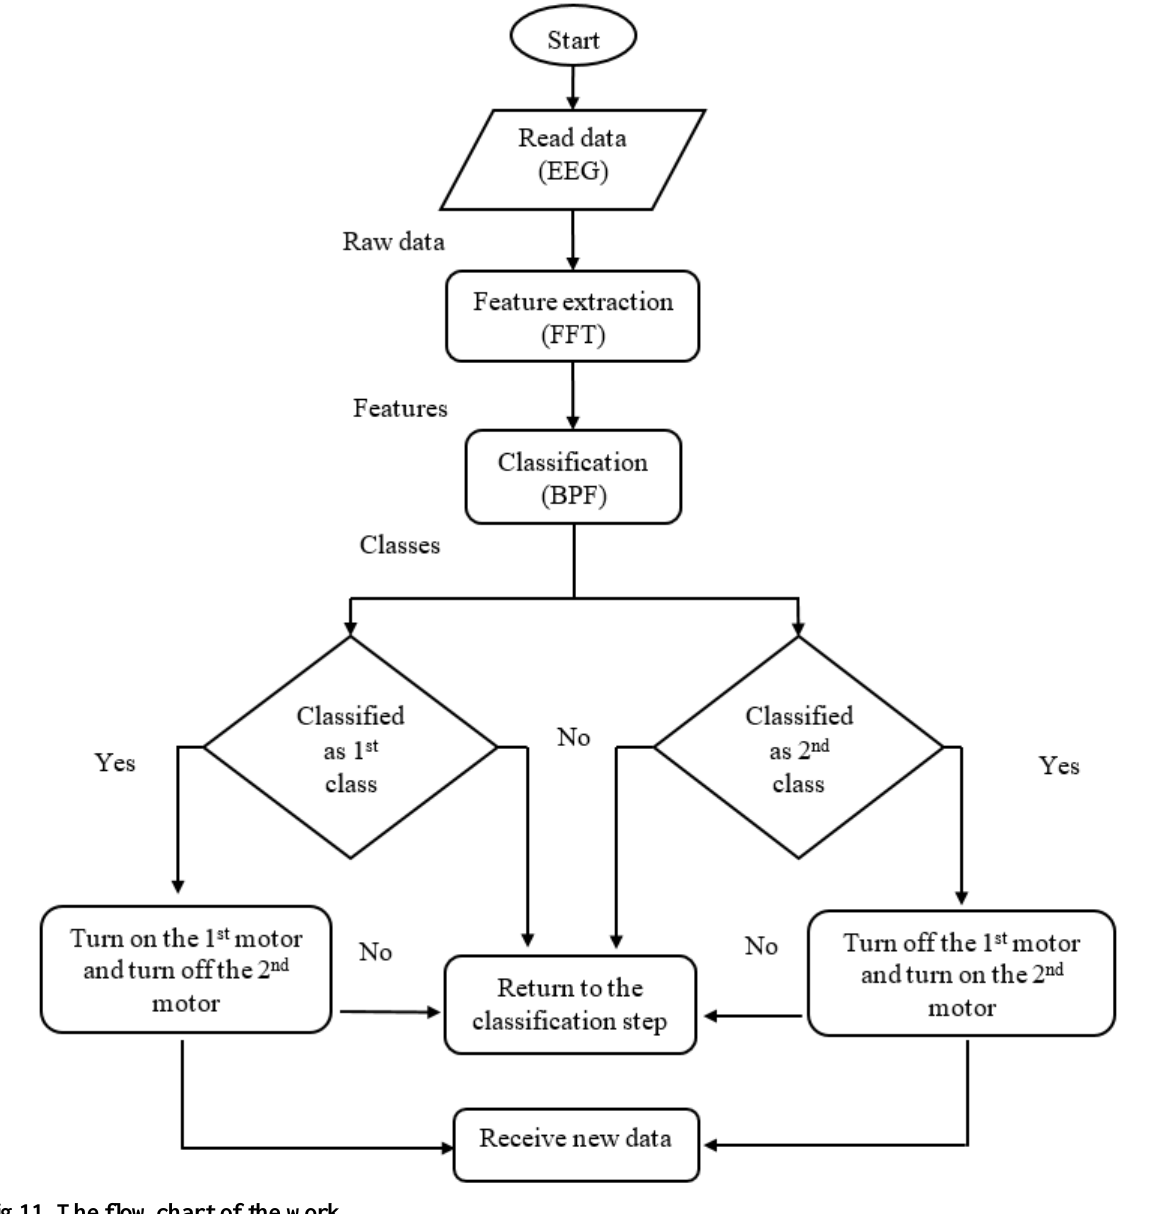
Fig.11. The flow chart of the